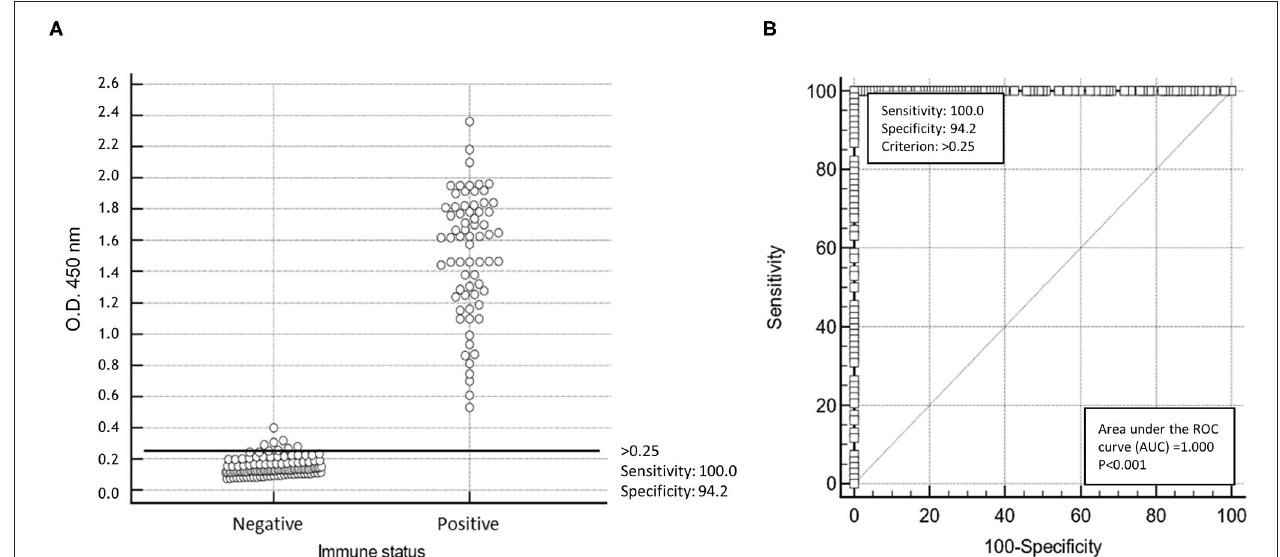
FIGURE 3 | Statistical analysis of His-VP3 ELISA. (A) A scatter plot of 86 positive and 102 negative (0 = negative; 1 = positive) sera using cut-off point optical density (O.D. 450 ) > 0.25. (B) Receiver operating curve (ROC) analysis for determination of specificity and sensitivity performances at the established threshold (O.D. 450 = 0.250; criterion > 0.25) of His-VP3